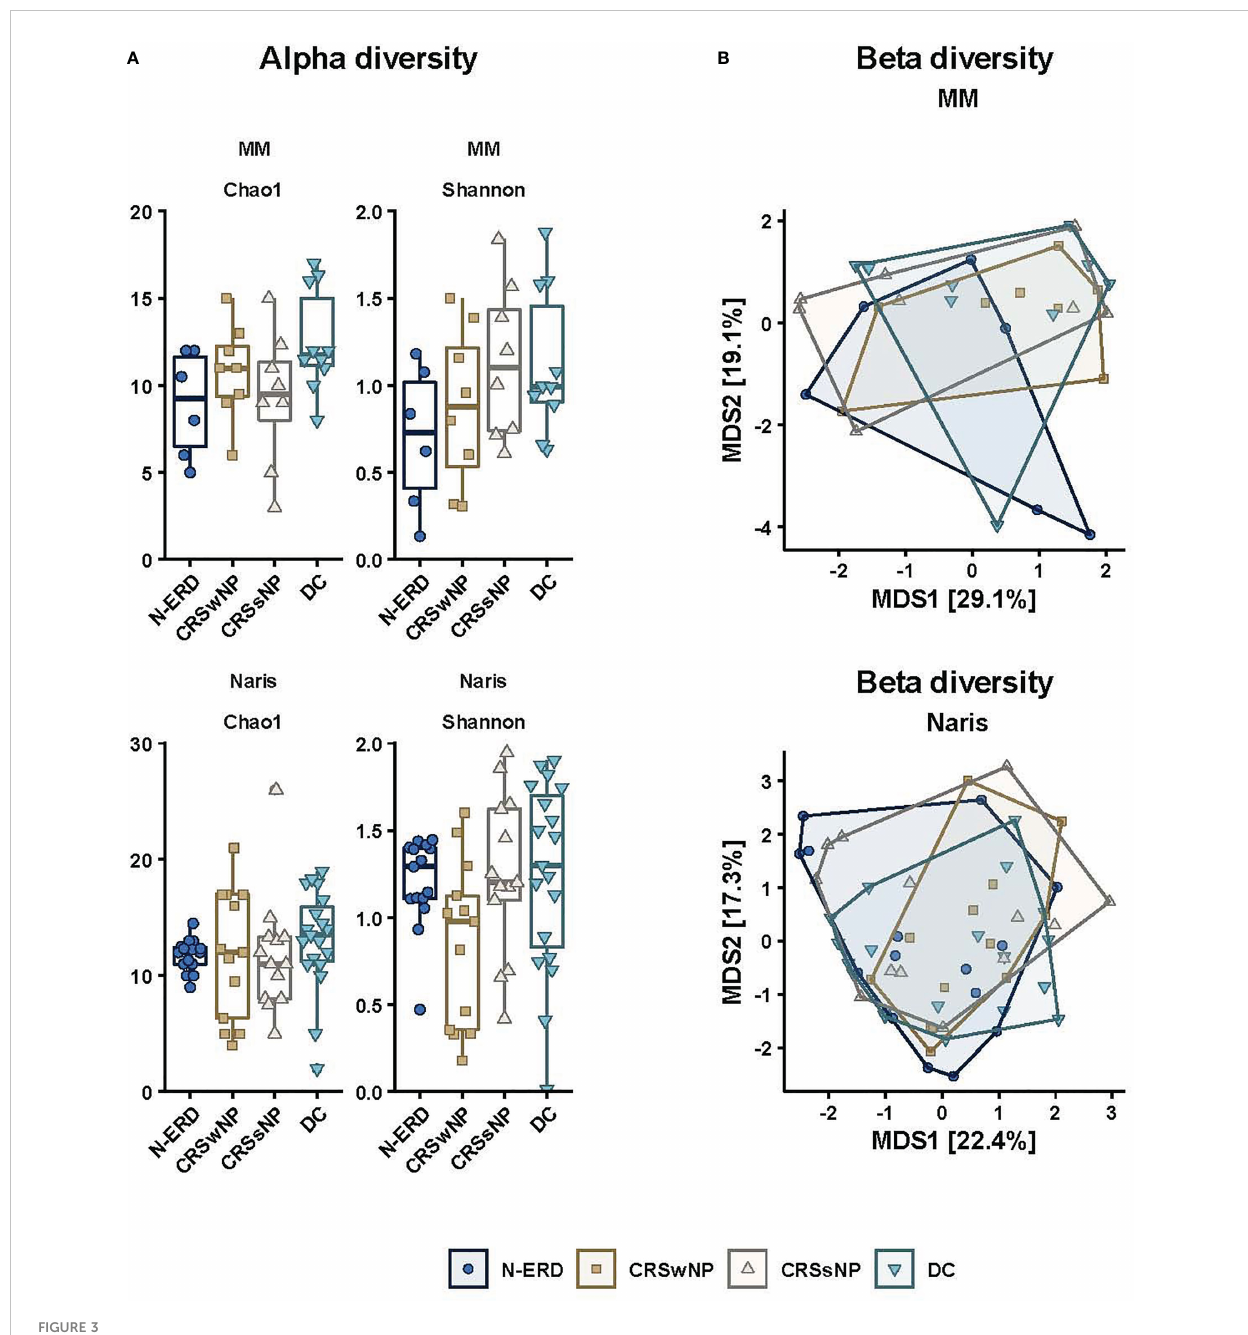
FIGURE 3 Alpha and beta diversity plots. (A) Alpha diversity divided into origin (anterior naris and middle meatus) and Chao1 richness values and Shannon diversity indices, (B) principal coordinates analysis plots (PCoA) showing beta diversity results of nasal microbial pro fi les divided into origin [anterior naris (AN) and middle meatus (MM)]; patients with CRSsNP (grey triangles, n AN =13, n MM = 8), CRSwNP (brown squares, n AN =13, n MM = 8) or N-ERD (dark blue circles, n AN =14, n MM = 7) as compared to disease controls (DC, light blue triangles, n AN =19, n MM =